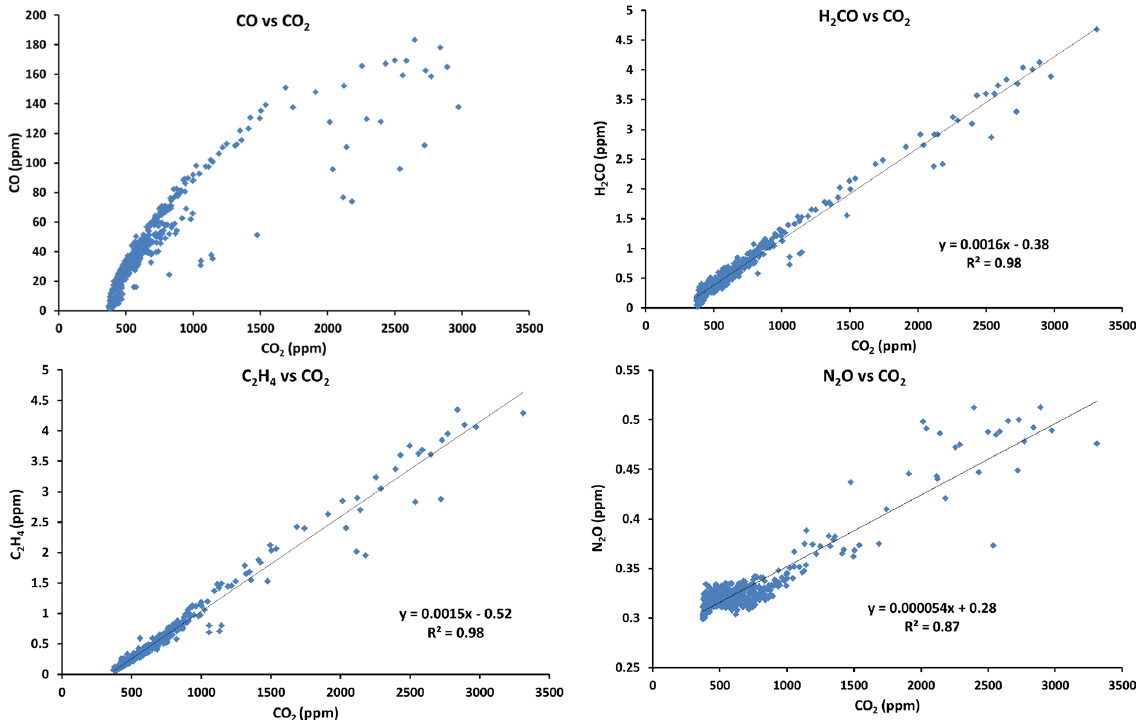
Figure 4. Example correlation plots with respect to CO 2 from the Alfords Point burn. Upper left-hand panel is CO vs. CO 2 ; upper right-hand panel is H 2 CO vs. CO 2 ; lower left-hand panel is C 2 H 4 vs. CO 2 and lower right-hand panel is N 2 O vs. CO 2